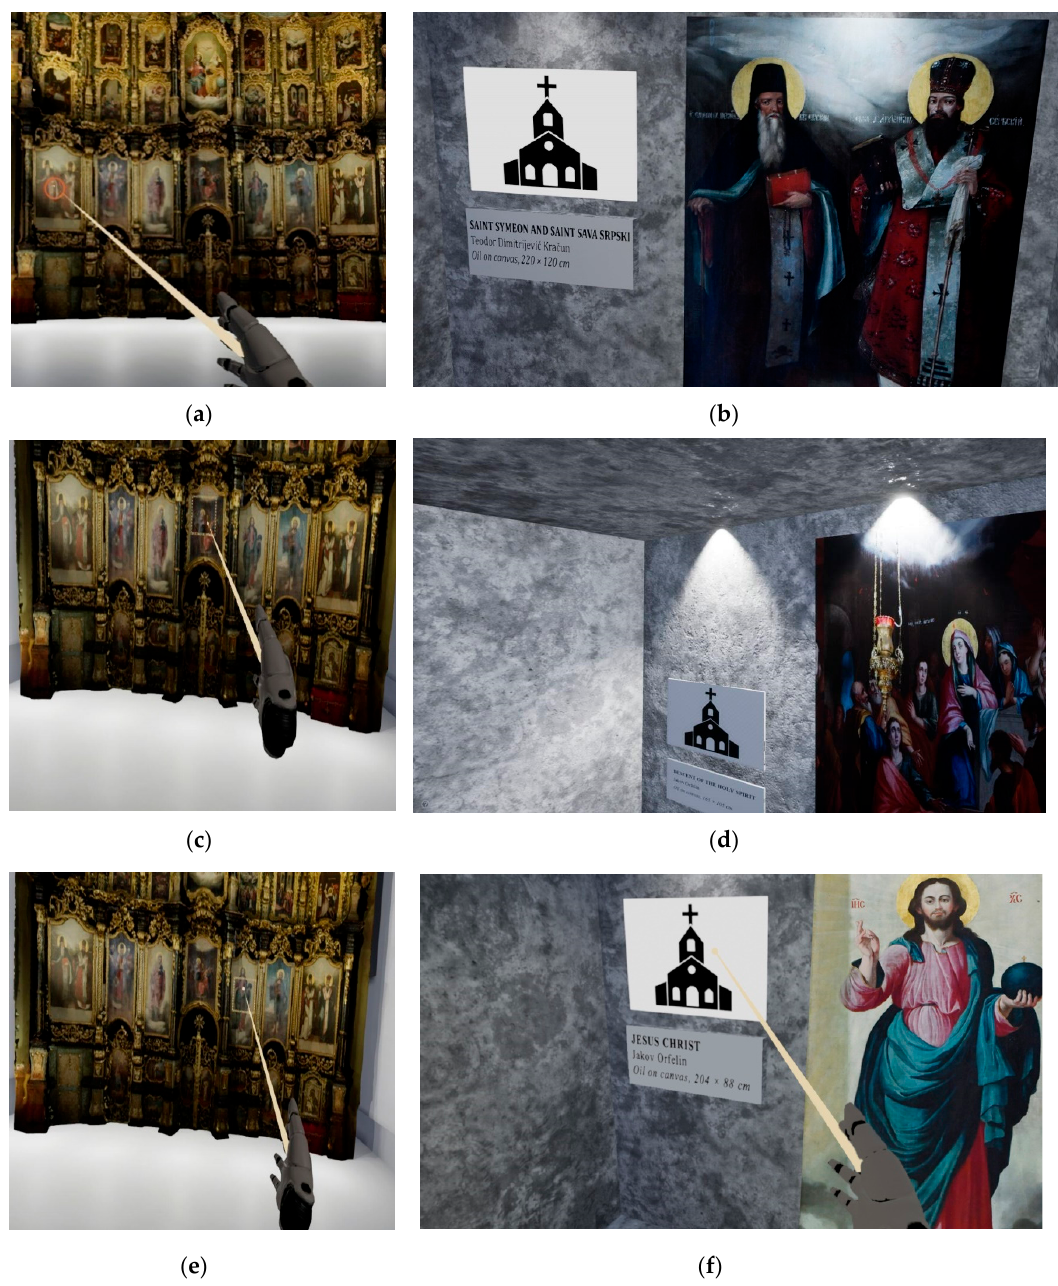
Figure 13. ( a , c , e ) Selecting specific interactive widget; ( b , d , f ) the isolated level with the image of icon and information about the technical details and author of the painting.